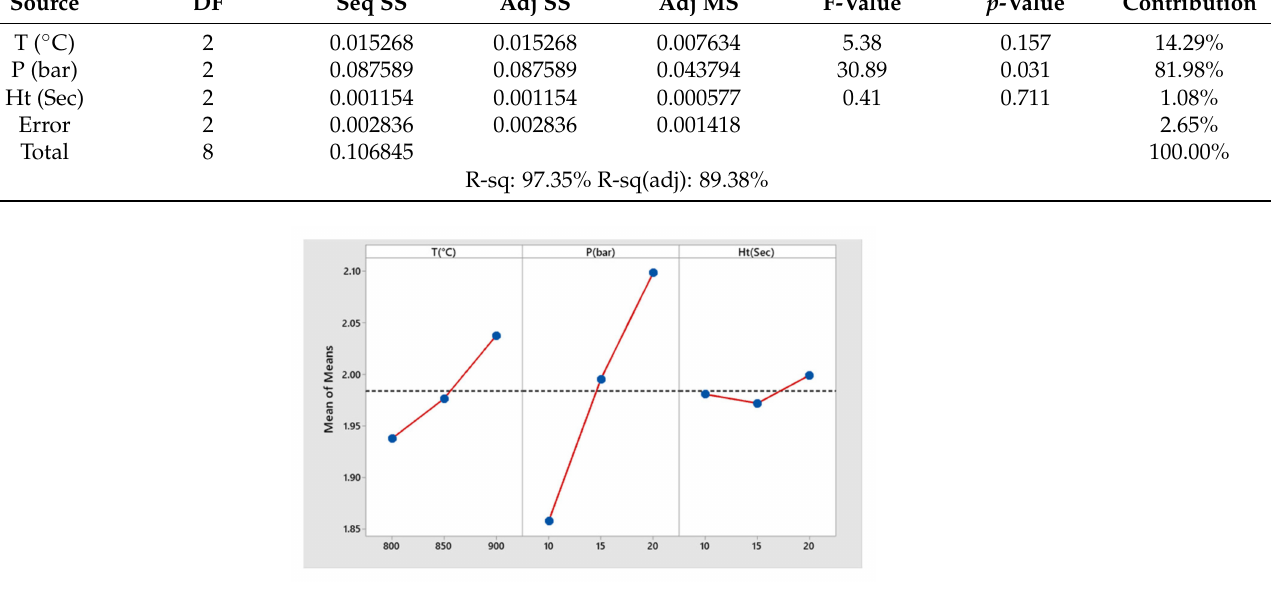
Figure 12. Main effect plot for the cooling rate at different experimental conditions.